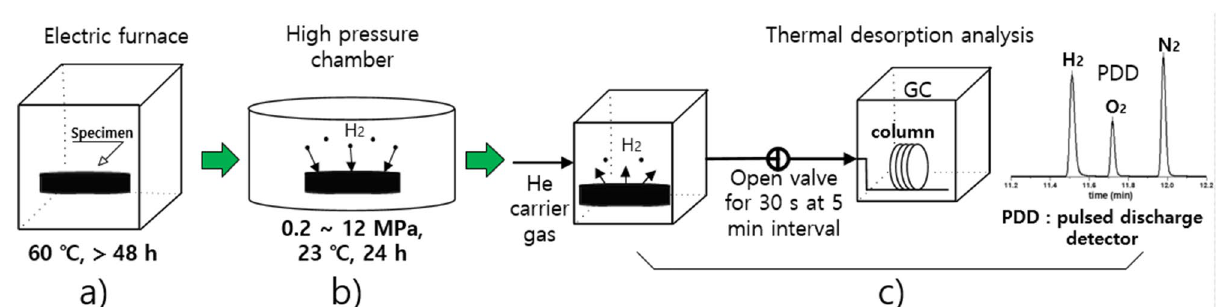
Figure 2. Schematic diagram of the overall TDA-GC measurement procedure. ( a ) heat treatment is performed at 60 ℃ for at least 48 h to minimize outgassing from the rubber, ( b ) hydrogen charging at room temperature and the desired pressure for 24 h. ( c ) the pressure is lowered to atmospheric pressure by opening the exhaust valve after the charging process, then, the specimen is removed to start the GC